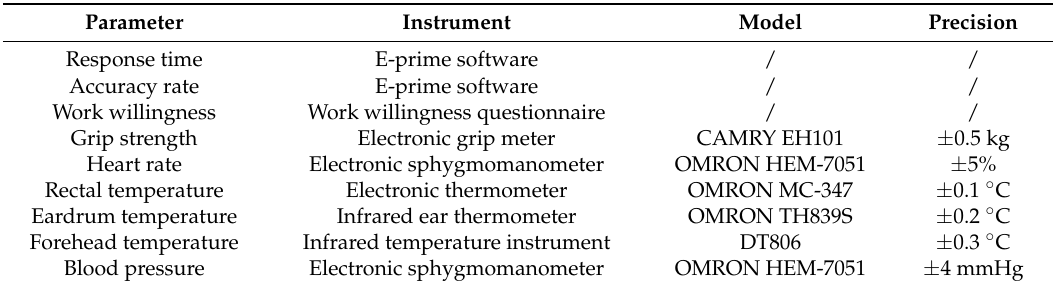
Table 2. Parameters and instruments.